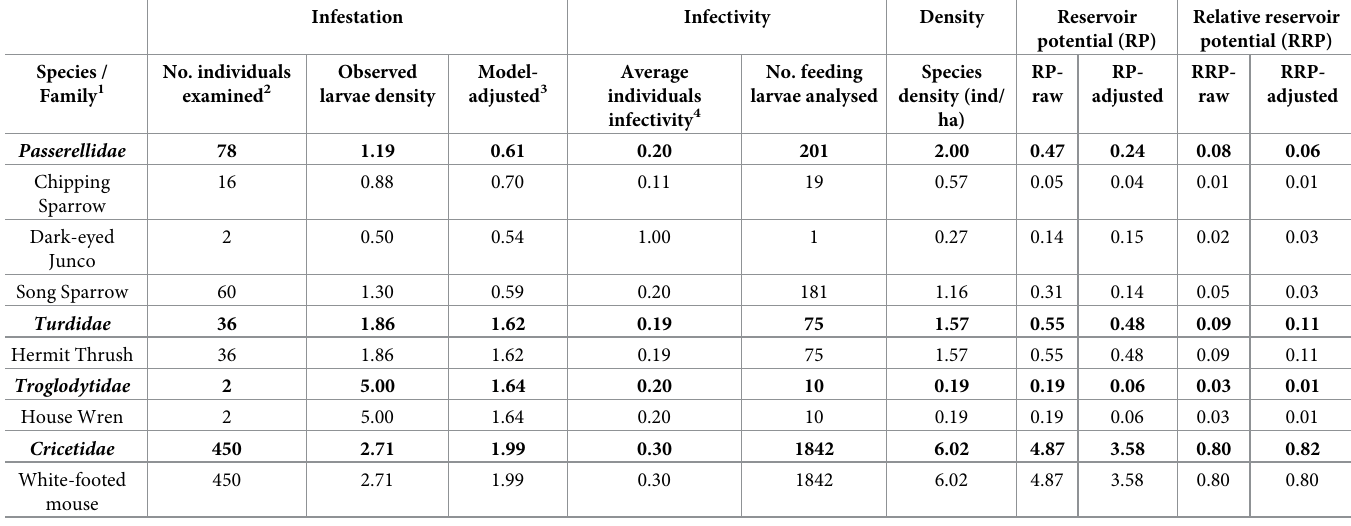
Table 5. A comparison of the reservoir potential for the hosts individuals in which we detected B . burgdorferi , grouped by species and by family.